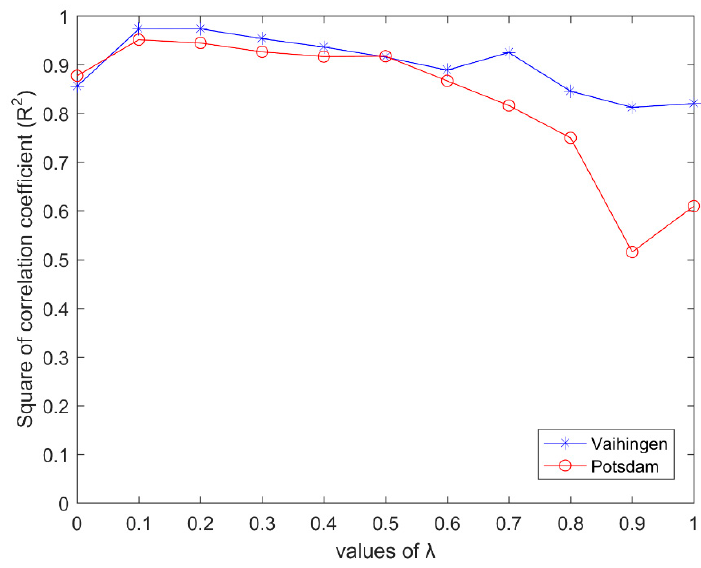
Figure 10. Relationship between parameter λ and the square of correlation coe ffi cient ( R 2 ).